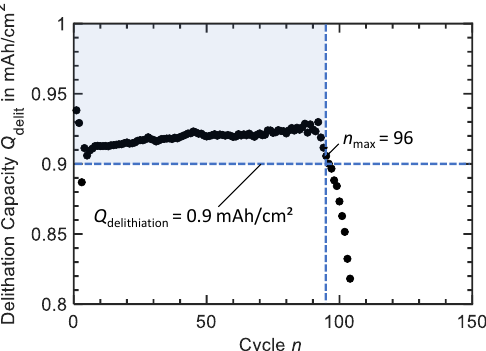
Figure 3. Schematic representation of our approach to analyse cycling results. We consider cycling experiments terminated as soon as the delithiation capacity Q delithiation of five consecutive cycles drops below 0.9mAh/cm 2 . The number of the last cycle with Q delithiation ≥ 0.9mAh/cm 2 represents the maximum number of valid cycles n max . Here the cycling performance of an etched brass foil versus Li is shown